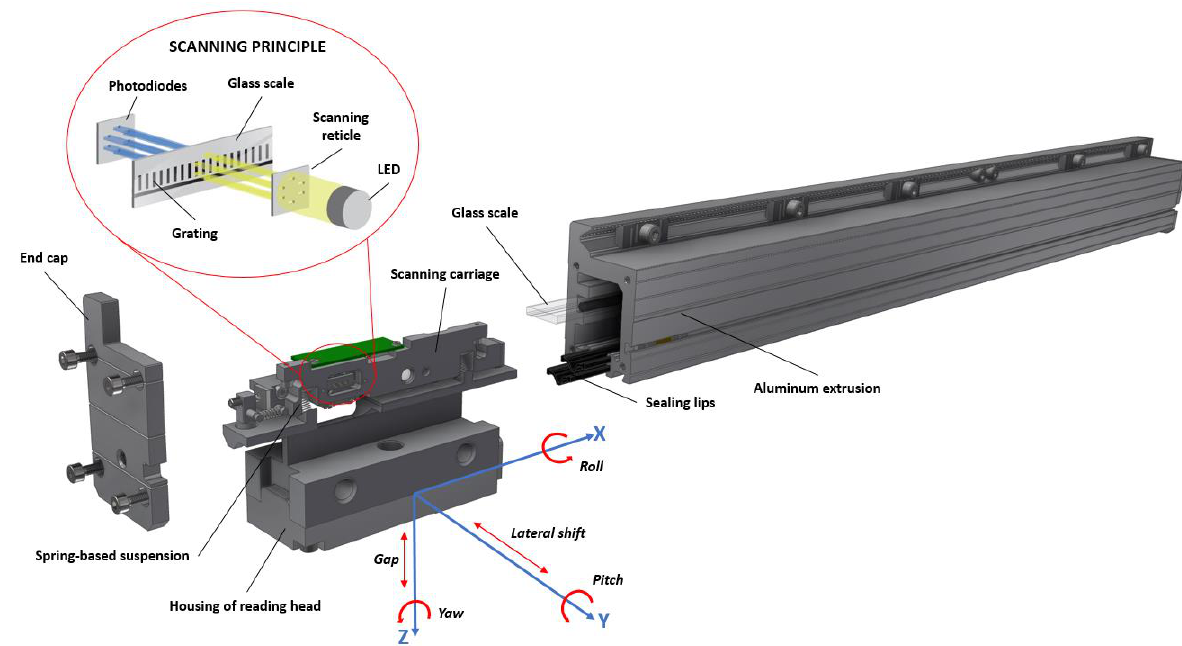
Figure 1. A basic principle scheme of a spring-based suspension of the experimental reading head.